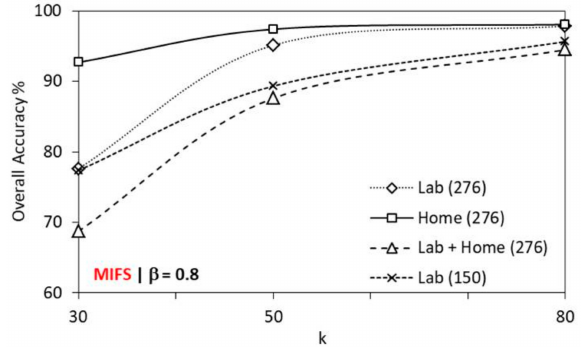
Figure 10. Performance of MIFS with k features on a di ff erent dataset.